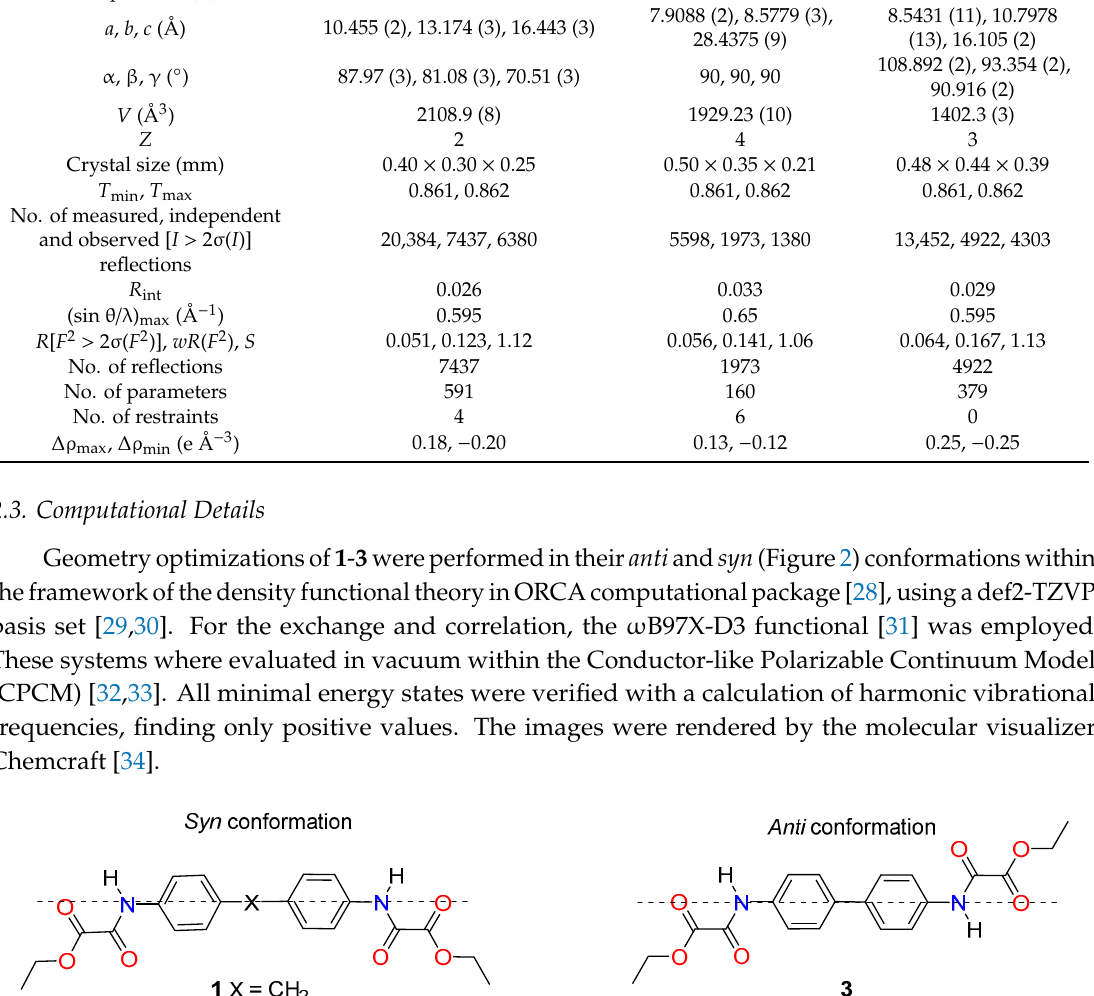
Table 1. Crystallographic data and refinement for 1-3 .